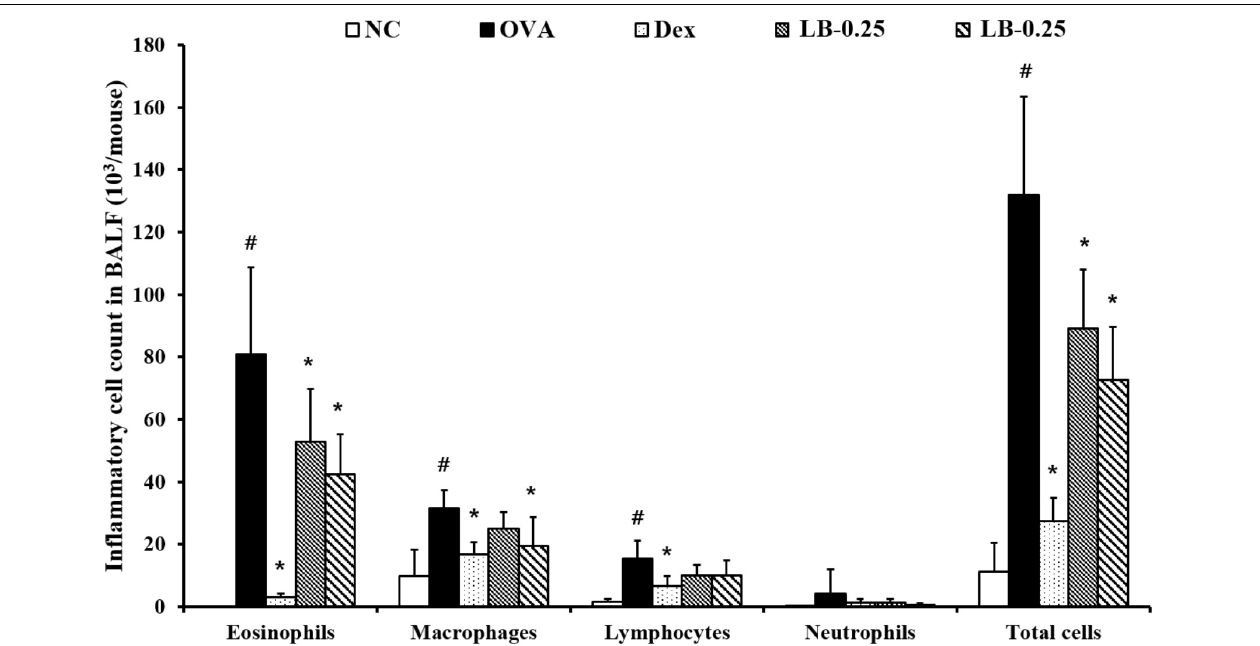
FIGURE 2 | Effects of lobeglitazone (LB) on the number of inflammatory cells in BALF from OVA challenged animals. Cells were isolated via centrifugation and stained with Diff-Quick stain reagent. NC, normal control mice; OVA, OVA-sensitized/challenged mice; Dex, dexamethasone (3 mg/kg) + OVA-sensitized/challenged mice; LB-0.25 and –0.5, LB (250 µ g/kg or 500 µ g/kg, respectively) + OVA-sensitized/challenged mice. Values are expressed as mean ± SD ( n = 6/group). # Significantly different from NC, P < 0.05. ∗ Significantly different from OVA, P <